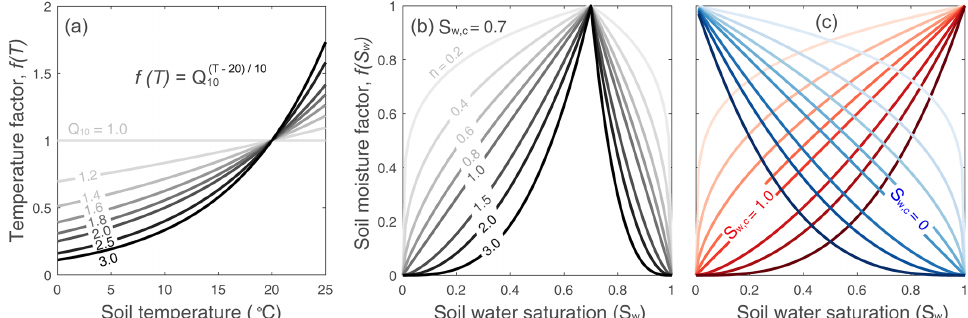
Figure 4. Reaction rate dependence. (a) Function form of soil temperature dependence and (b, c) soil moisture dependence for reaction rates. The f (T ) takes the Q 10 form (Eq. 8). The soil moisture factor f (S w ) depends on S w , c and n and soil water saturation S w (Eq. 9). The soil moisture function can represent three types of behaviors: the threshold behavior ( b , 0 < S w , c < 1), increase behavior (red in c , S w , c = 1), and decrease behavior (blue in c , S w , c = 0). Values of n = 1 lead to a linear threshold dependence of S w , while n < 1 and n > 1 lead to concave and convex dependences,